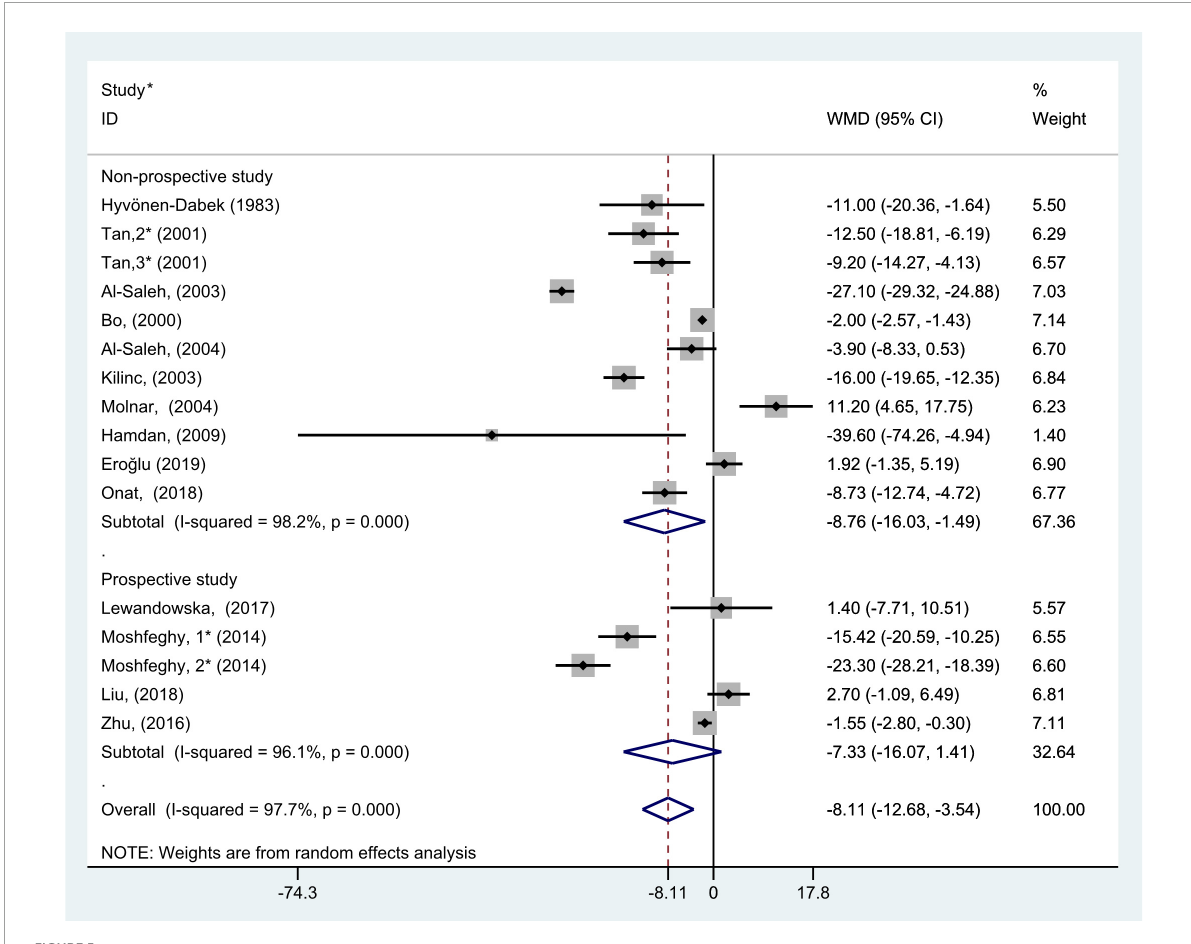
FIGURE5 Subgroup analysis of blood selenium level in patients with gestational diabetes mellitus and healthy pregnant women based on study types. The random effects model is applied. For studies in which blood selenium levels were measured during different pregnancy periods in one study, 1, 2, and 3 are used to denote measurements performed in the first, second, and third trimesters, respectively. *First author (year of study